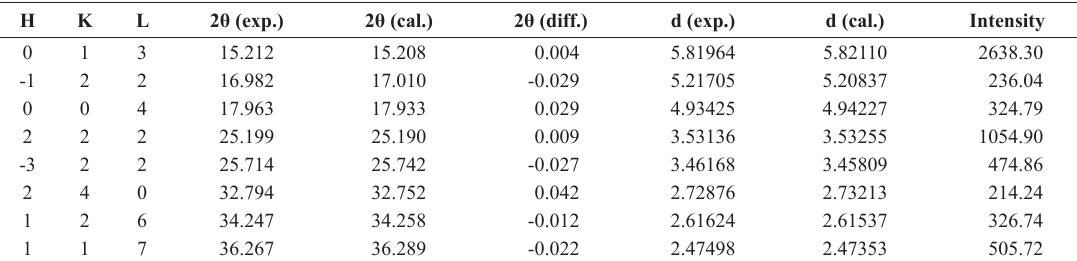
Table 1. Evaluated parameters from XRD data of dopant metal